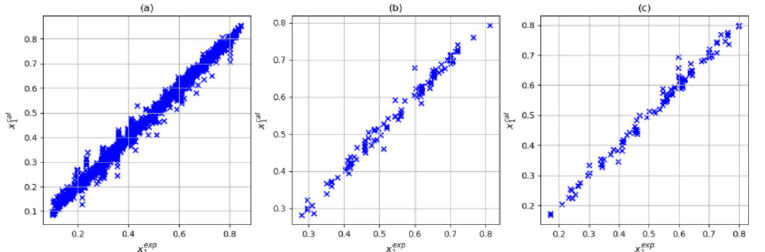
Figure 7. Correlation between experimental data and those calculated by ANN using T, P, Tc, Pc, and Zc inputs with (5,6,8,1) architecture: ( a ) training dataset, ( b ) testing dataset, and ( c ) prediction dataset.